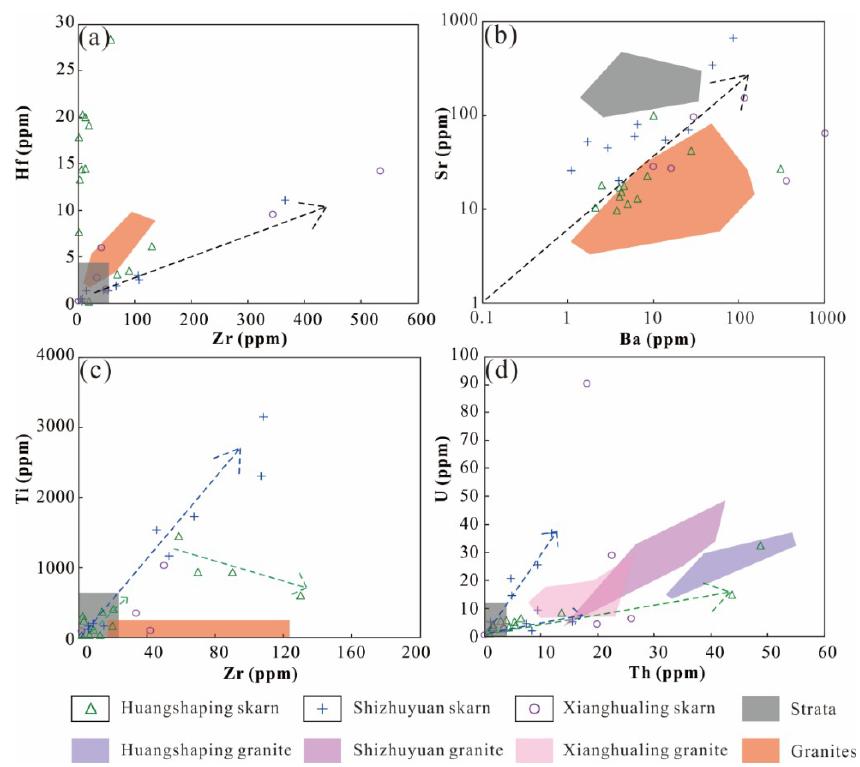
Figure 10. Correlation of trace elements in skarns, illustrating the geochemical behavior of typical trace elements during metasomatism. ( a ) Zr vs. Hf diagram; ( b ) Ba vs. Sr diagram; ( c ) Zr vs. Ti diagram and ( d ) Th vs. U diagram. The colored arrows are provided to highlight correlation trends (black arrow shows overall trend for all skarns, with the green arrow for Huangshaping and blue arrow for Shizhuyuan). The orange box shows the range of composition of all granites from the three deposits and the gray box shows the range of composition of the Carboniferous limestone at Huangshaping and Devonian limestone at other deposits in the Nanling range. Data sources are the same as in Figure 8.